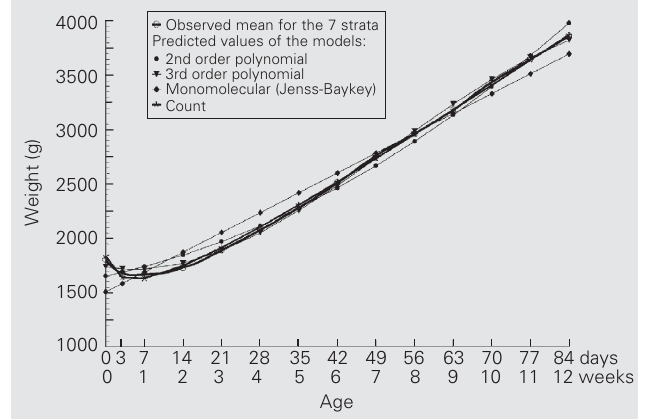
Figure 2. Mean weight of preterm newborns by birth weight category adjusted by the method of